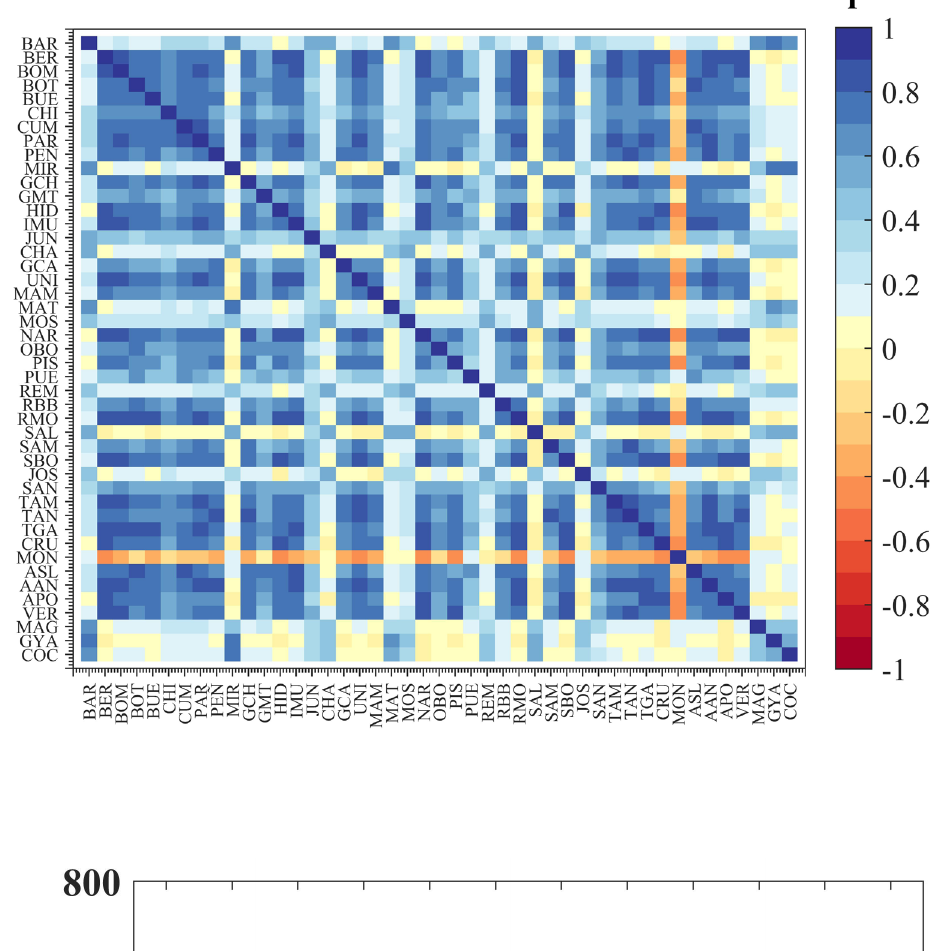
Figure 5. Monthly mean rainfall regime for the period 1983-2016 of MON gauge station. Lower and upper box boundaries are 25th and 75th percentiles, respectively, line inside the box is median, lower and upper error lines are 10th and 90th percentiles, respectively, the hollow point is the mean.